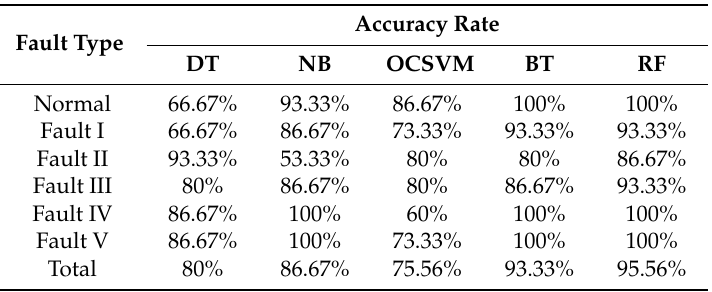
Table 6. Diagnosis results after feature space optimization.